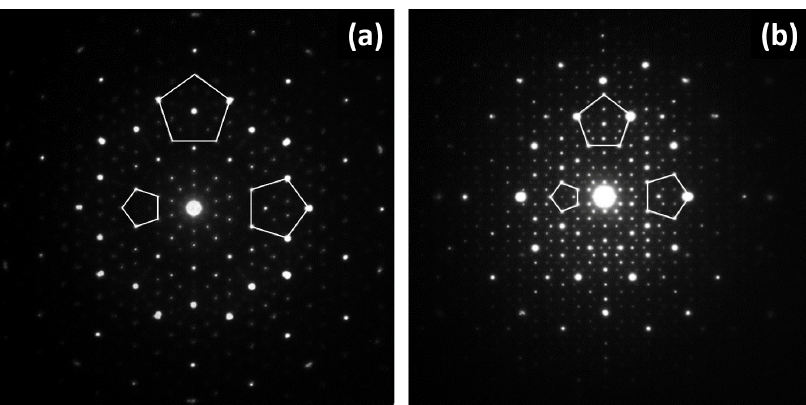
Figure 5. Comparison of electron diffraction patterns in [010] zone axis: decagonal quasicrystal in Al–Co-Cu system ( a ), ε 16 decagonal quasicrystalline approximant in Al–Pd–Co system ( b ). The surface structure of SCIPs is significantly less understood compared to bulk